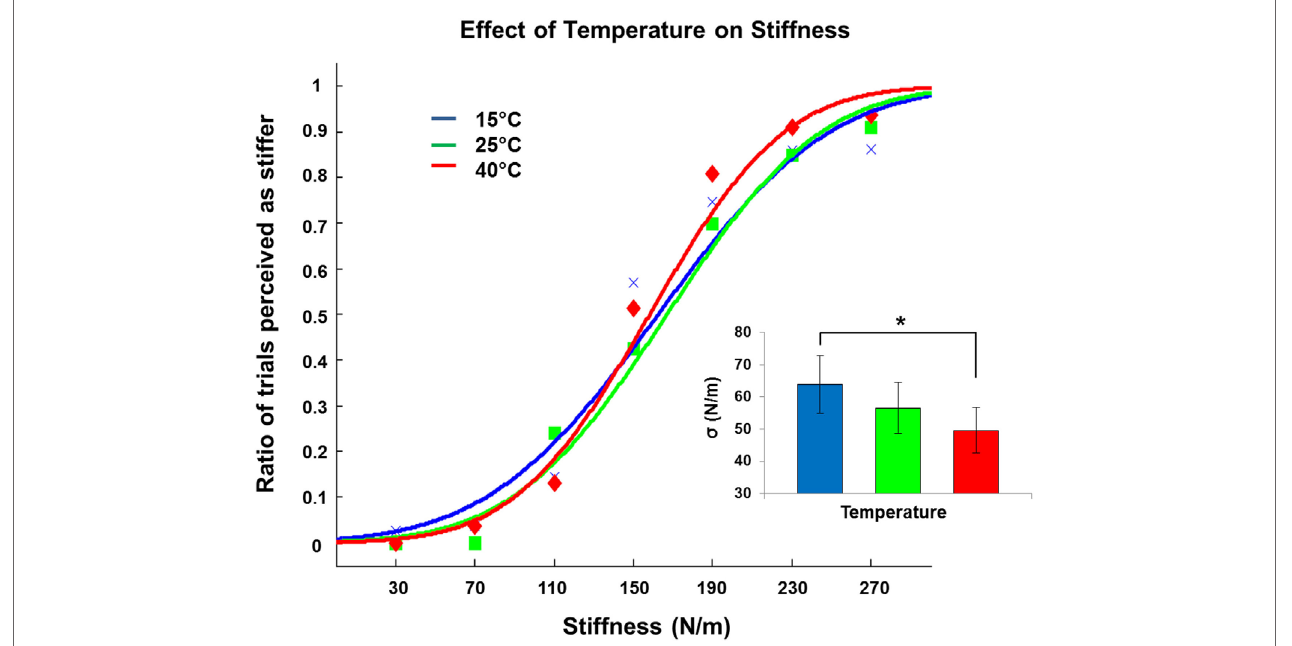
FigUre 7 | effect of temperature on stiffness perception . The psychometric curve for each of the three temperatures is shown. To obtain these curves, participants judged the relative stiffness of two successive virtual surfaces (the standard of 150 N/m and the test) at each given temperature (15, 25, or 40°C) in a two-alternative forced-choice task. The curves are obtained by plotting the percentage of trials perceived as stiffer than the reference stiffness against the seven stiffness combinations, for each given temperature. The inset shows the σ for each curve. Note that the σ during warmest temperature was significantly smaller (higher precision, steeper psychometric curve) than the condition with coldest temperature stimulation. Error bars indicate 68.2% non-parametric confidence